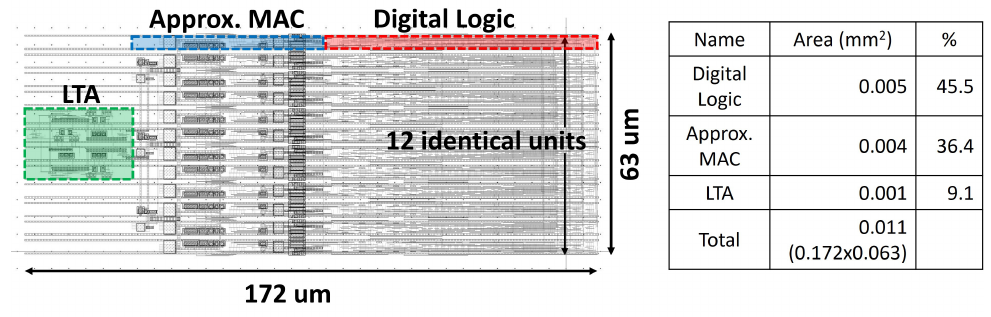
Figure 9. The layout of the proposed “K-means clustering